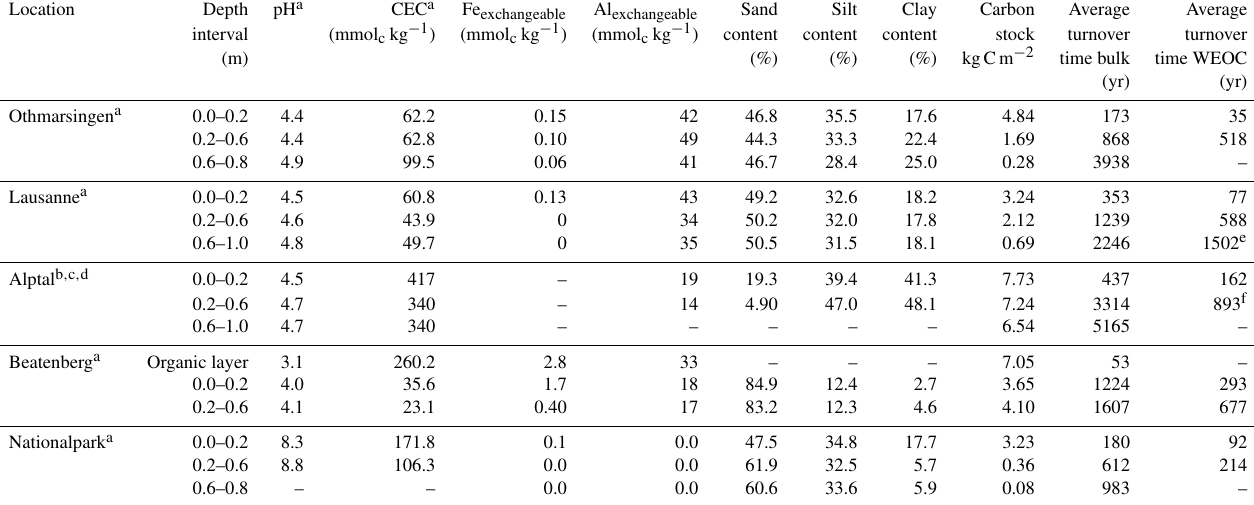
Table 3. Soil properties as well as carbon stocks and fluxes in 0–20, 20–60, and 60–100cm depths of the study sites for the bulk and water-extractable organic carbon (WEOC).